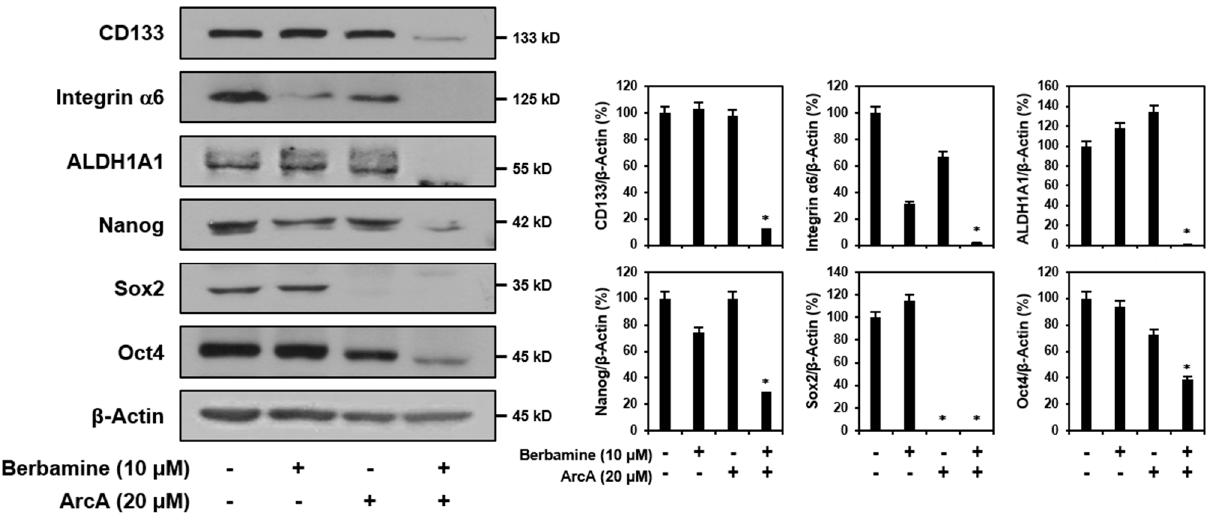
Figure 4. Combined treatment of berbamine and ArcA synergistically suppresses expression of GSC markers. U87MG-derived GSCs were treated with the indicated concentrations of berbamine and ArcA for 24 h. Protein levels were detected by Western blot analysis using specific antibodies and were further quantified by densitometry. β -Actin levels were used as an internal control. * p < 0.05 vs. the compound alone or the control.